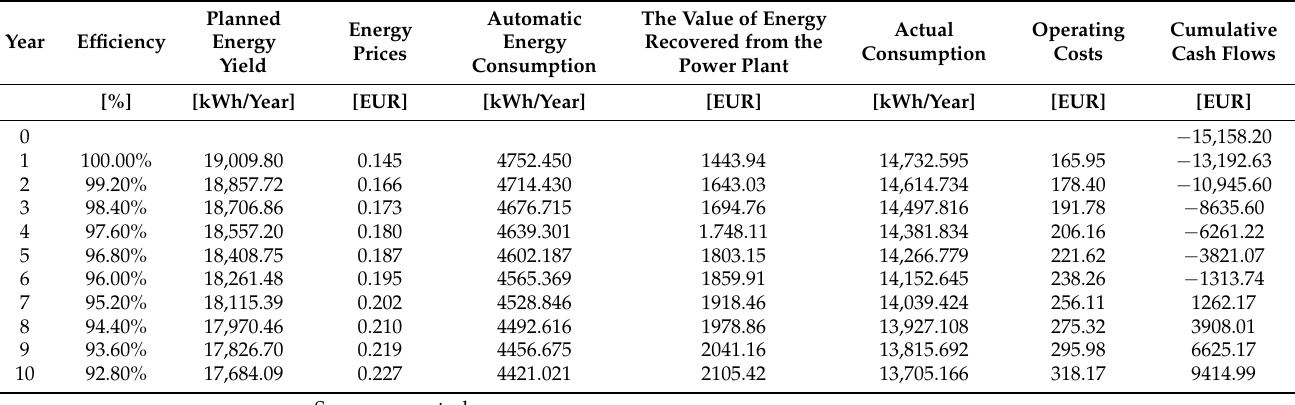
Table 3. Summary and analysis of accumulated cash flows for heating with a heat pump powered by a photovoltaic installation.